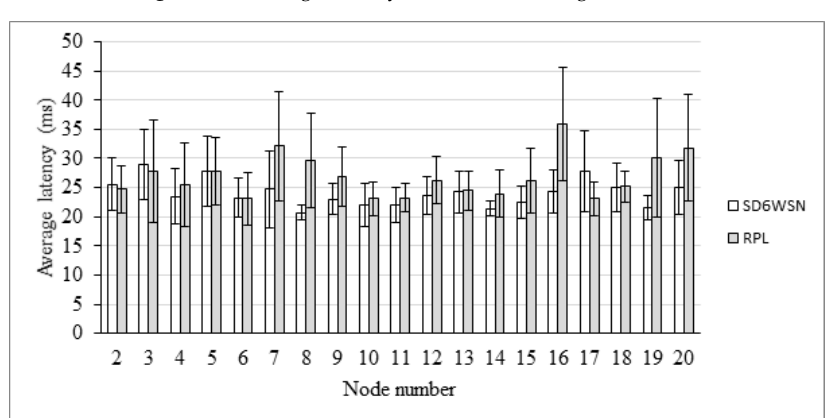
Figure 20. Average latency for the 100 m-range scenario.